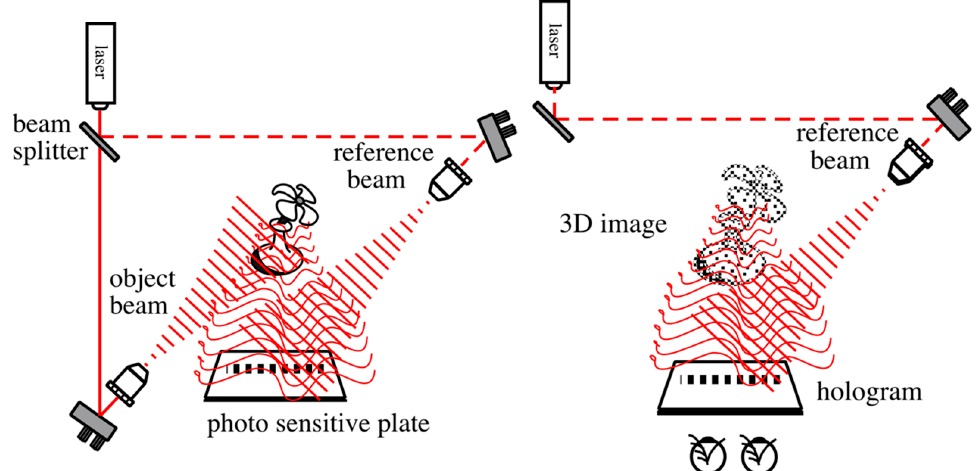
Figure 4. Creating and viewing an off-axis transmission hologram: photo-sensitive material receives an interference pattern between a reference beam and light reflected from an object. When the resulting hologram is illuminated with the same wavelength of monochromatic light at the same position as the reference beam, a 3D image of the object is reconstructed and visible through the plate.